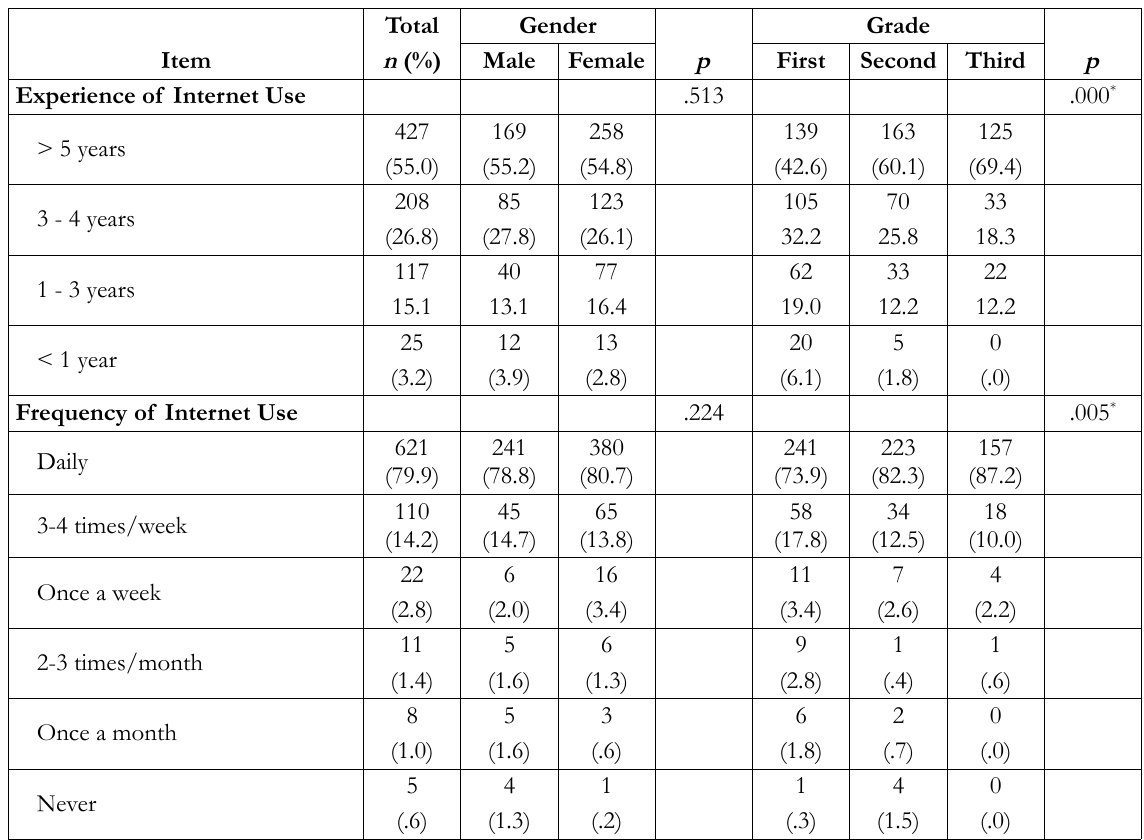
Table 2. Experience and frequency of internet